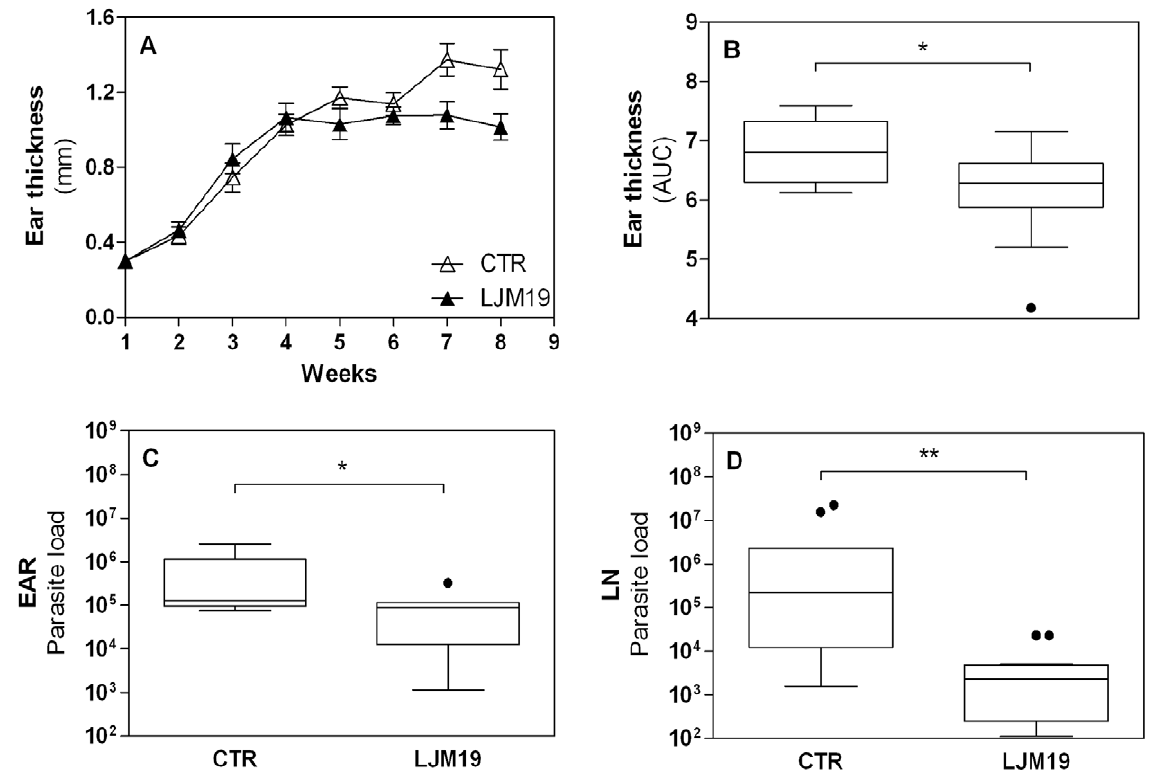
Figure 4. Ear thickness and parasite load in LJM19 immunized hamsters following infection with L.braziliensis . Hamsters (12 per group total) were inoculated three times in the right ear with DNA plasmid coding LJM19 salivary protein (closed triangle) or empty DNA plasmid (CTR - open triangle) and were challenged intradermally in the left ear with 10 5 L. braziliensis stationary promastigotes in the presence of Lu. intermedia SGS. The course of lesion development was monitored weekly and points represent the means and standard errors of the means (A). The areas contained underneath the curves (AUC) obtained in A for each group was compared (B). Five weeks after the infection, the parasite load was evaluated in the ear (C) and draining lymph node (D) by LDA, estimated by ELIDA. Experiments were repeated three times and were evaluated by Mann-Whitney non- parametric t test. *p , 0.05; **p , 0.01.